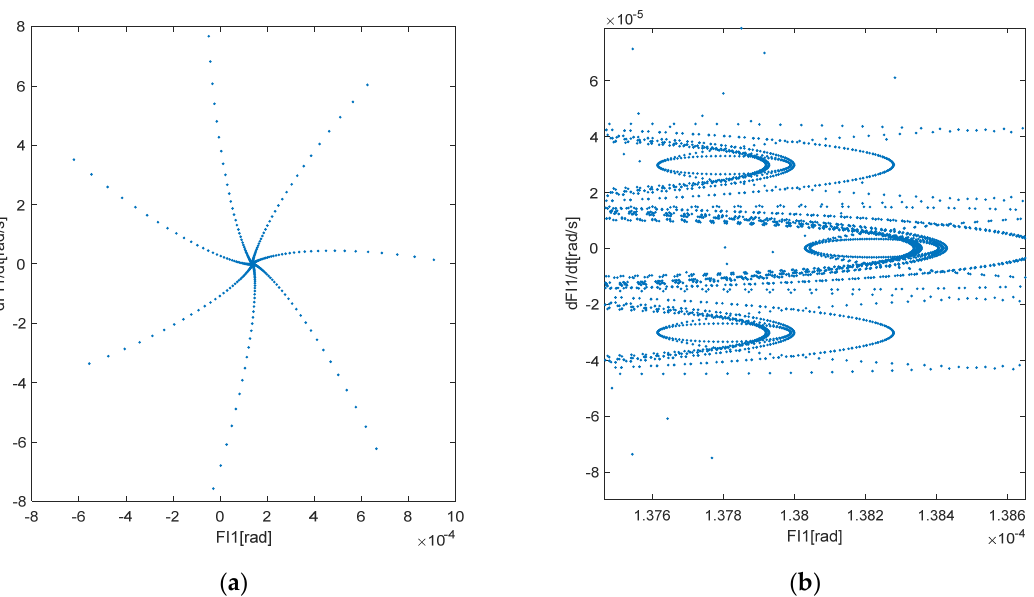
Figure 25. Poincaré Map of DIE1 for Figure 25. Poincar é Map of DIE1 for β 1 = 9 0 , ξ = 1.6 · 10 − 3 , η 1 = 3066.5Hz ( a ) N = 50,000 ( b ) N = 10,000.